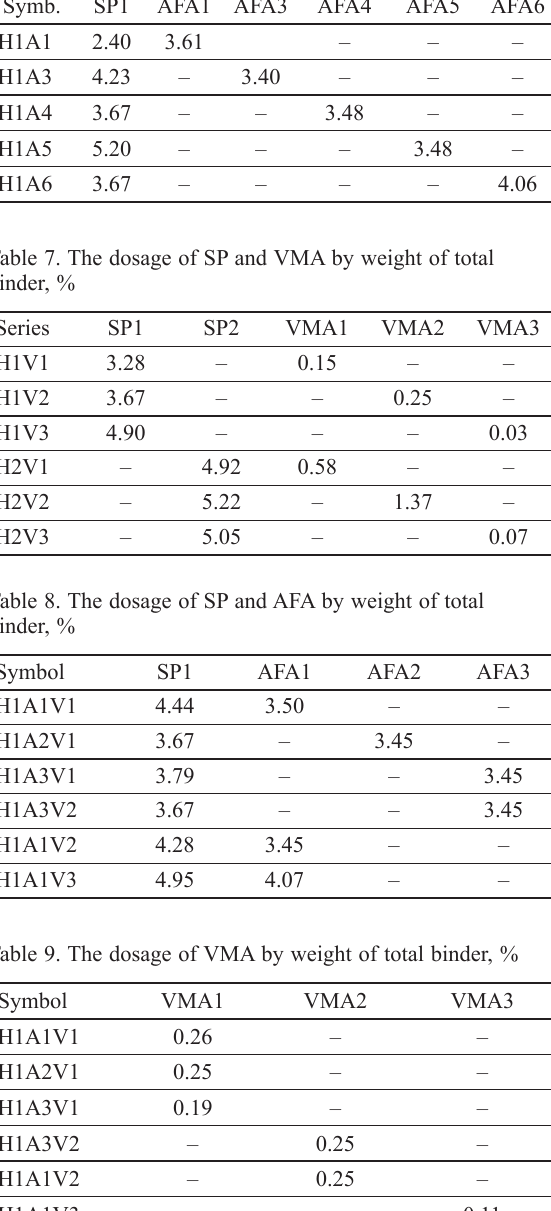
Table 6. The dosage of SP and AFA by weight of total binder, % Symb.